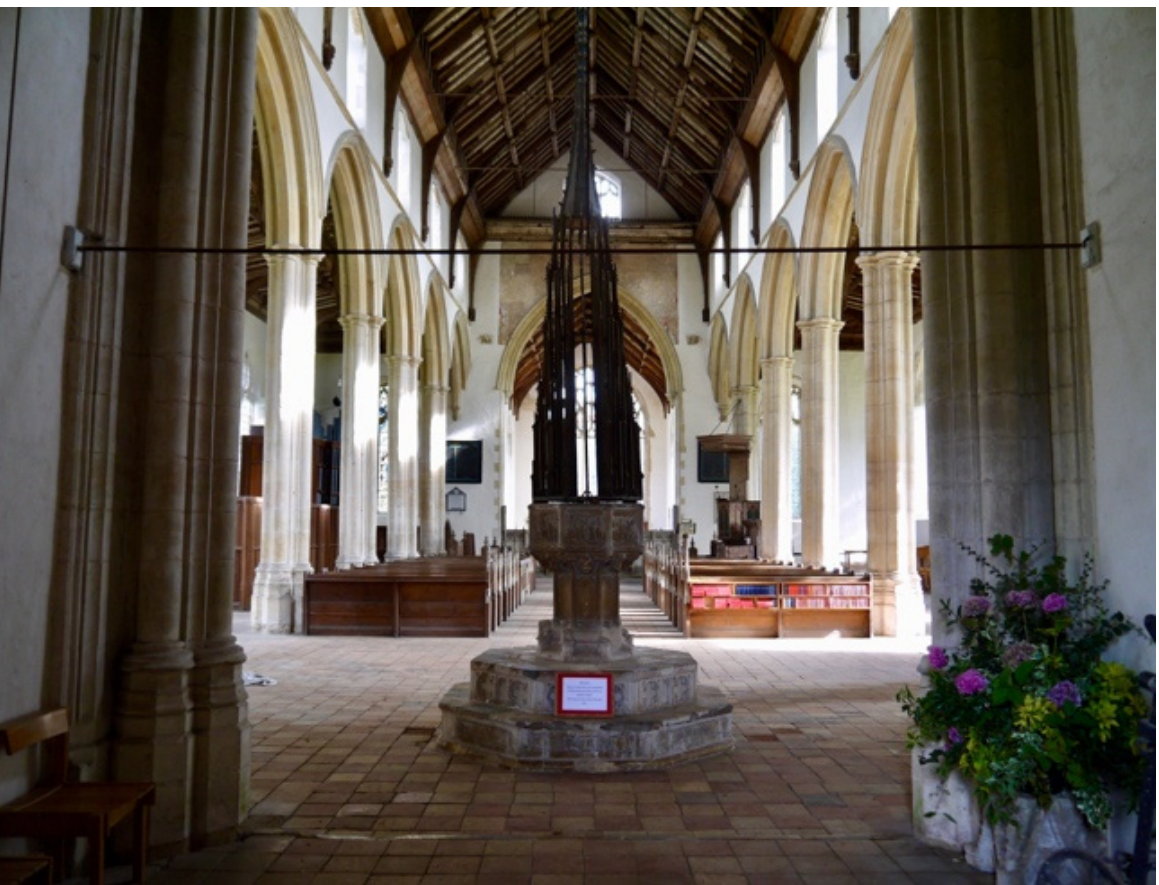
Figure 5. The font at St Peter and St Paul at Salle, as seen from the west